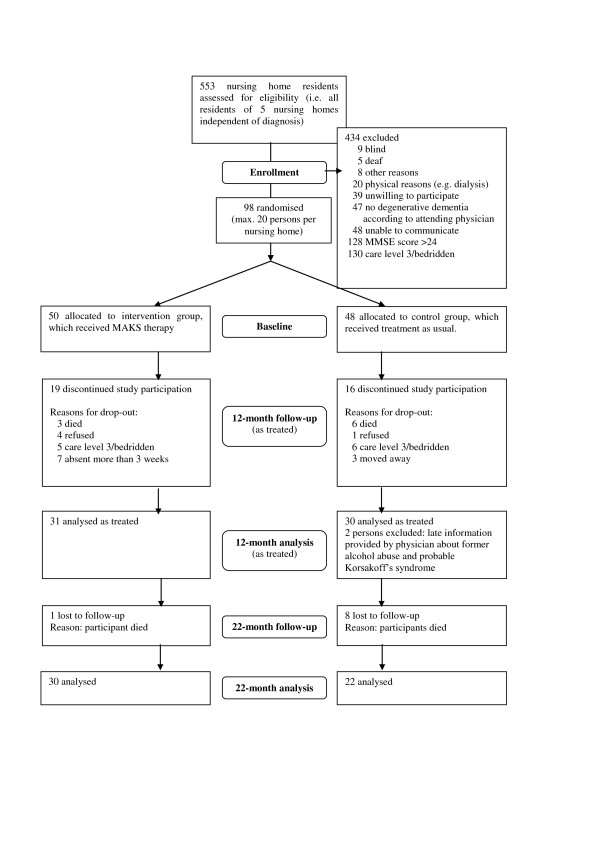
CONSORT flowchart.